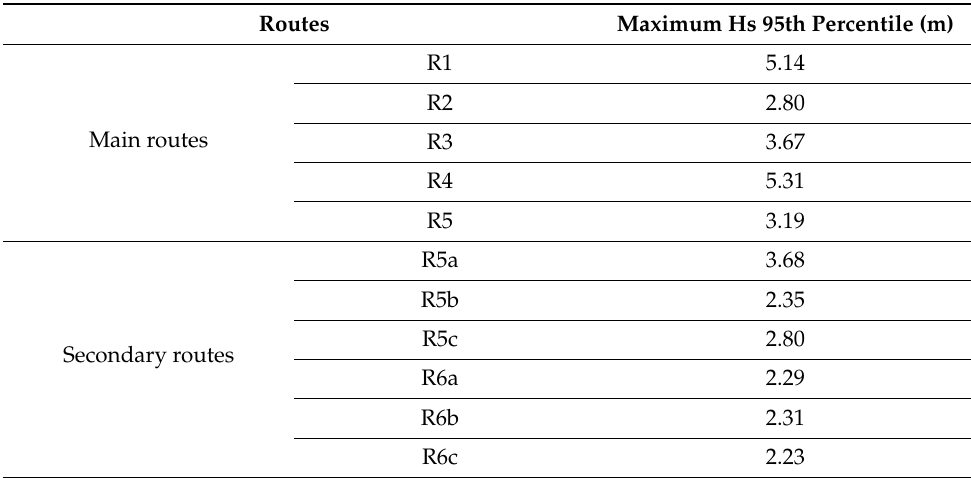
Table 5. Maximum Hs 95th percentile on each route considered in this